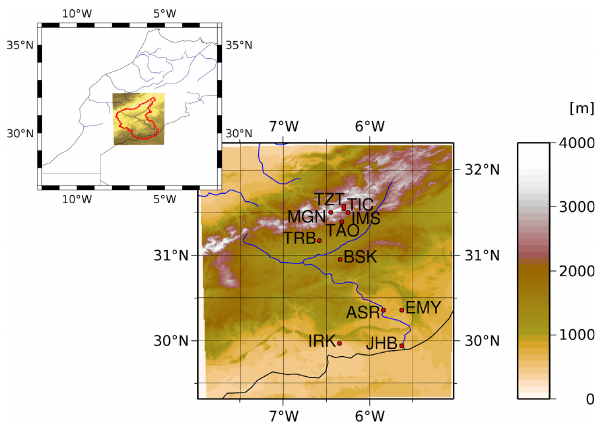
Fig. 1. Upper and middle Drˆaa Catchment and positions of the eleven IMPETUS weather stations and topography from digital el- evation model.